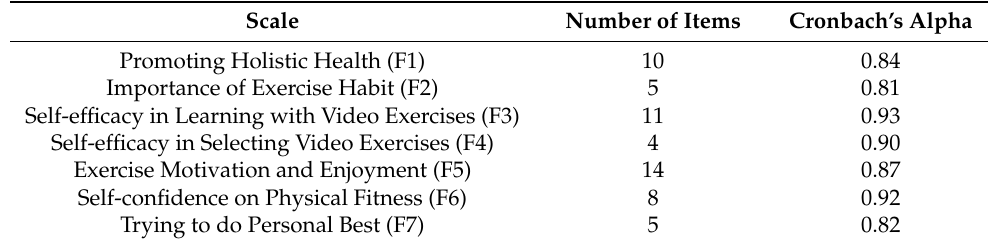
Table 2. Cronbach’s Alpha Reliability Analysis of APAS for Singapore Students ( n =